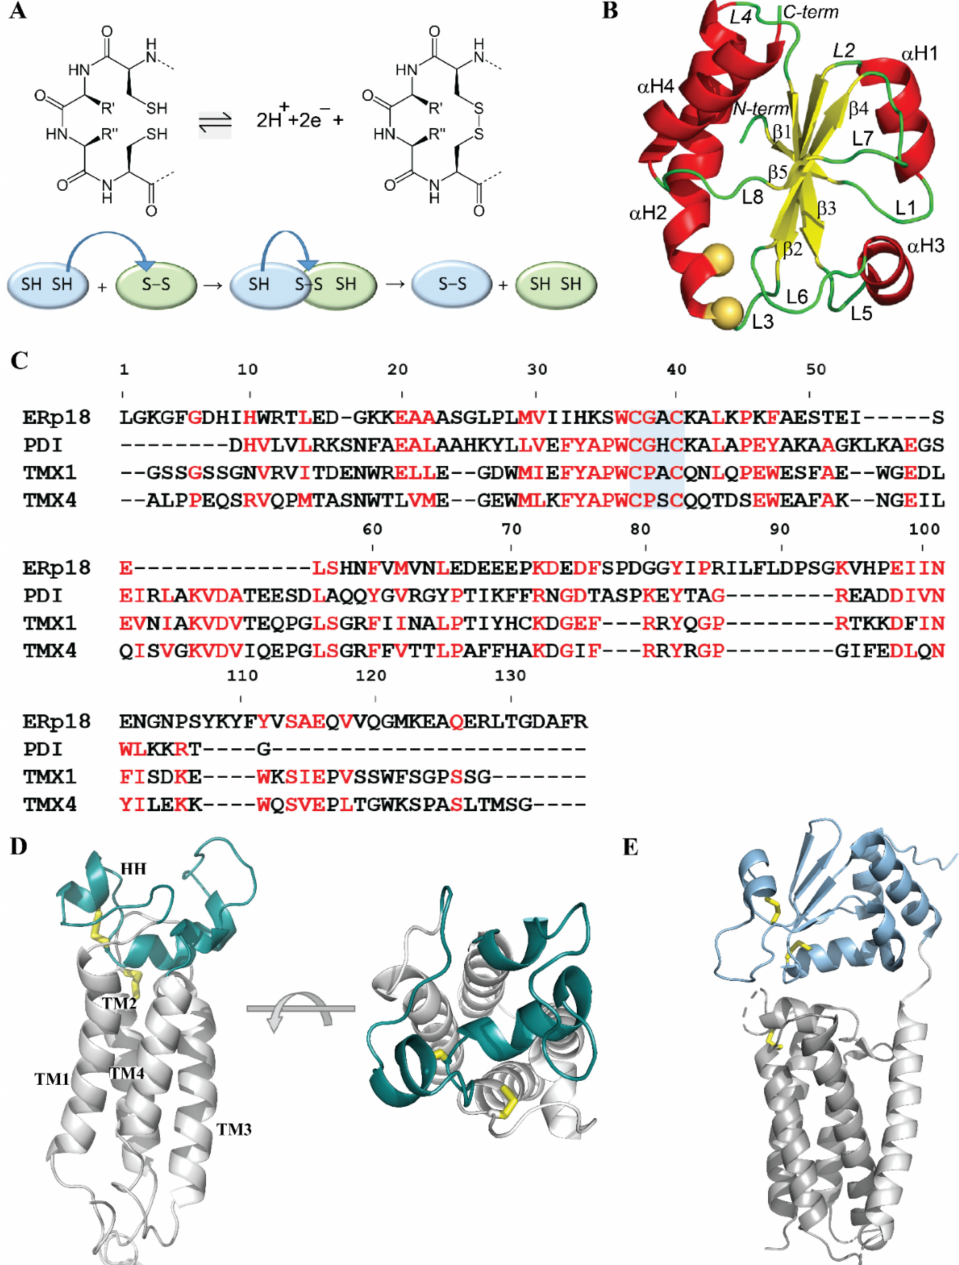
Figure 1. Thioredoxin-fold protein as a physiological reductant of human vitamin K epoxide reductase complex 1 (hVKORC1). ( A ) Oxidation of the two cysteine residues in the CX 1 X 2 C motif of Trx-fold proteins forms a disulphide bond, a process associated with the loss of two hydrogen atoms and, hence, two electrons (top). Mechanism of disulphide exchange between Trx and a target (bottom). The H -donor enzyme and a target are coloured in blue and green, respectively. ( B ) The Trx-fold is illustrated using the X-ray structure of human PDI deposed in PDB [5] (PDB ID: 4ekz). The protein is shown as red ribbons, with two cysteine residues from the CX 1 X 2 C motif as yellow balls. The four α -helices (in red), five β -strands (in yellow) and eight loops (in green) are numbered. ( C ) Comparison of the sequences of Trx-fold proteins ERp18, PDI, Tmx1 and Tmx4. Sequences were aligned on ERp18, having the most elongated sequence with ESPript3 (http://espript.ibcp.fr/). The